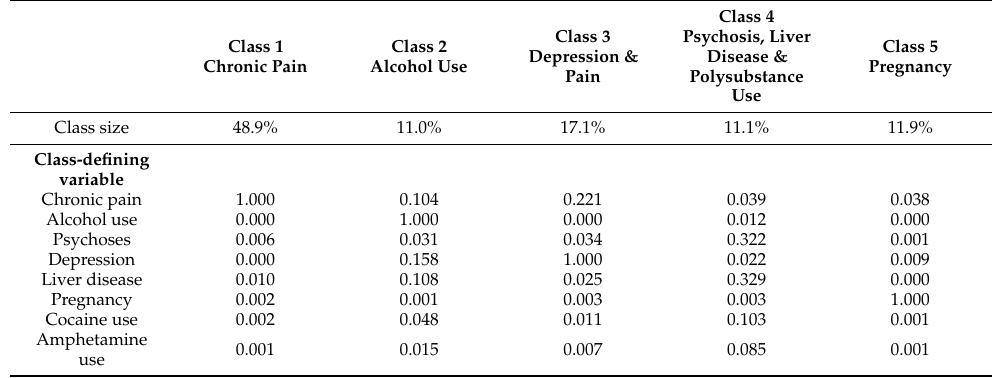
Figure 1. Radar plots for five subphenotypes of ED patients with opioid-related encounters. Table 2. Heat map of 5-class LCA model by class estimate of candidate class-defining variables.